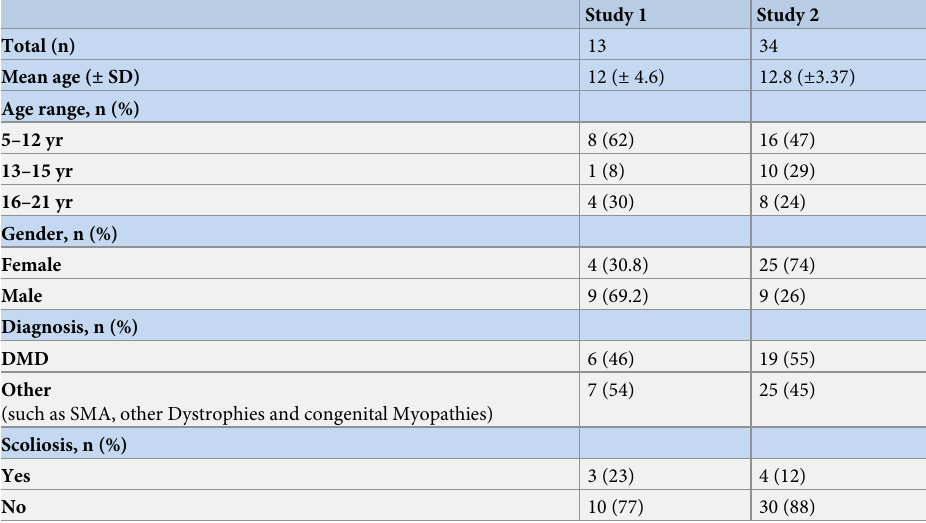
Table 1. Patient demographics for study 1 and study